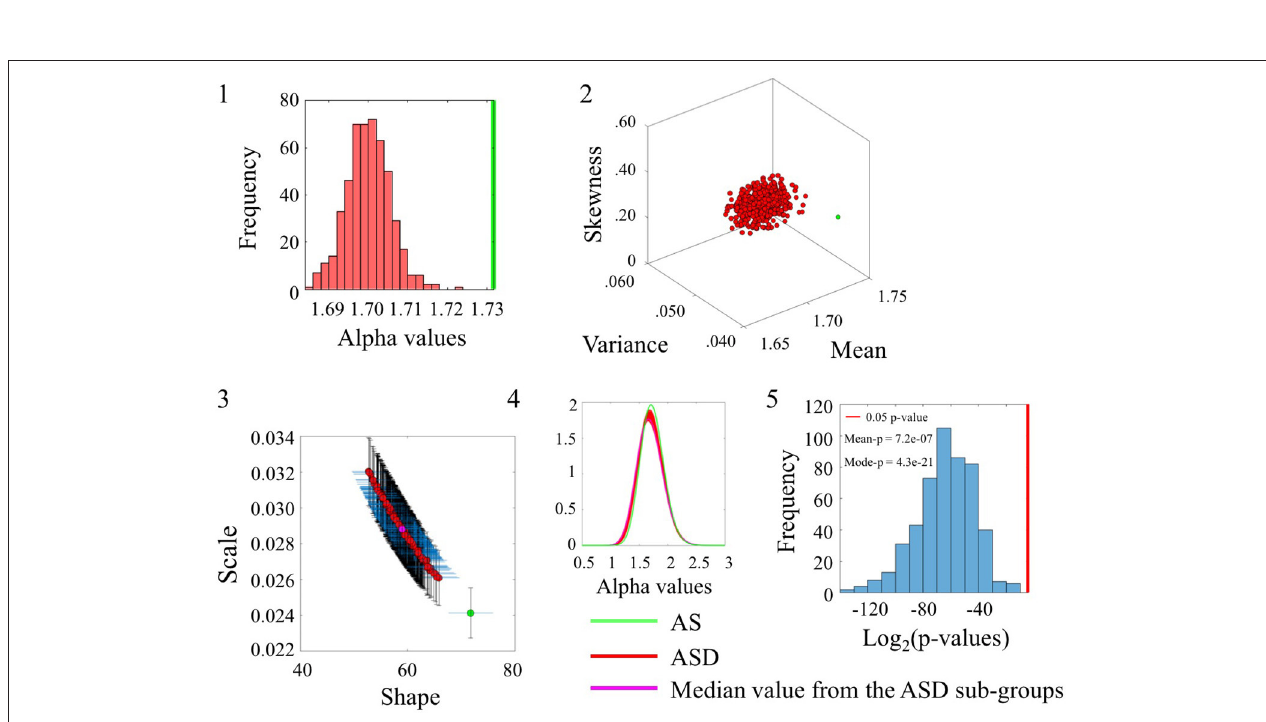
FIGURE 6 | Comparison between ASD DSM and AS groups for the Linear Speed (SR0 groups). Figure format is similar to Figures 4 , 5 .